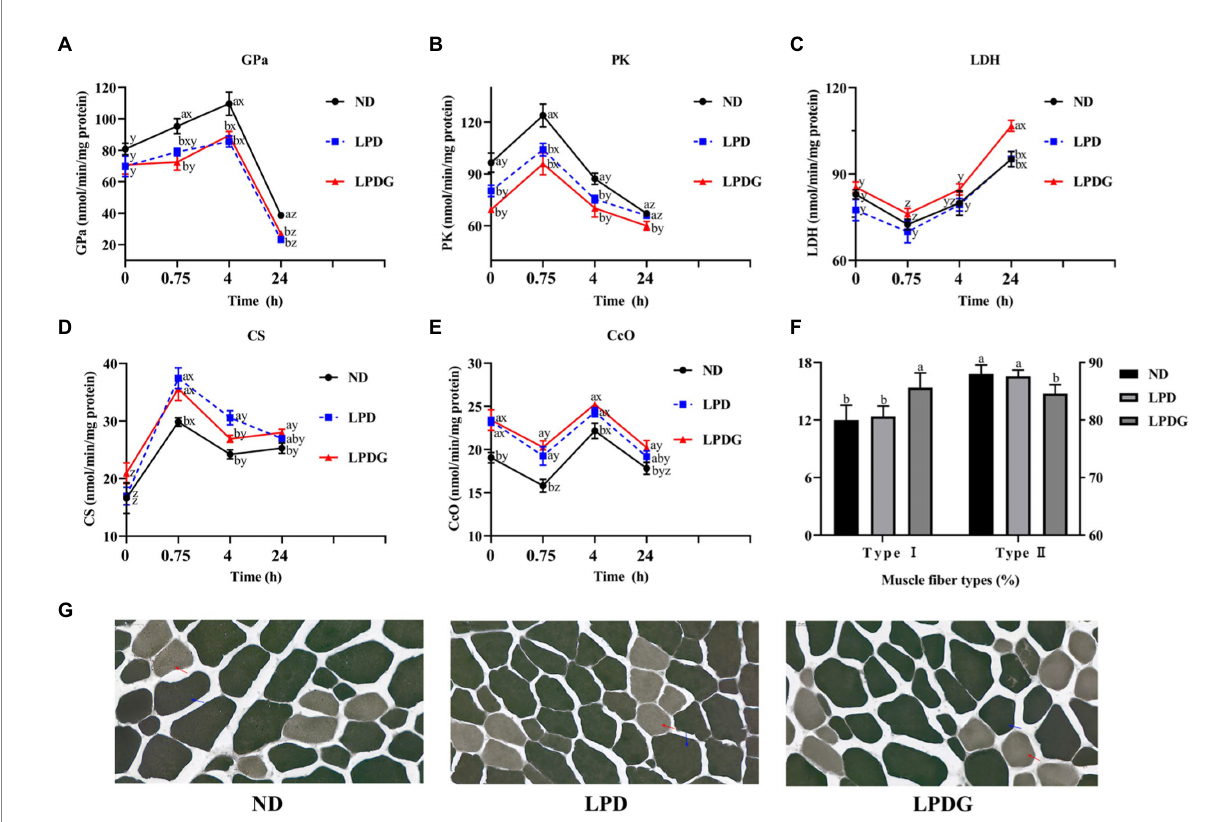
FIGURE 1 Metabolic enzyme activities and muscle fiber type composition of LT muscle from pigs receiving a normal, low protein, or low protein supplemented with glycine diet. (A - E) : glycogen phosphorylase a (GPa), pyruvate kinase (PK), lactate dehydrogenase (LDH), citrate synthase (CS) and cytochrome c oxidase (CcO) activities determined in LT muscle within 24 h PM. (F) : the percentages of type I and type II muscle fibres within LT muscle. (G) : histochemical staining of m-ATPase. LPDG increased the percentage of type I (red arrow), but decreased the number of type II muscle fibers. ab At the same PM time point, means lacking a common letter differ at p < 0.05. xyz Within the same dietary treatment, means lacking a common letter differ at p < 0.05. n =